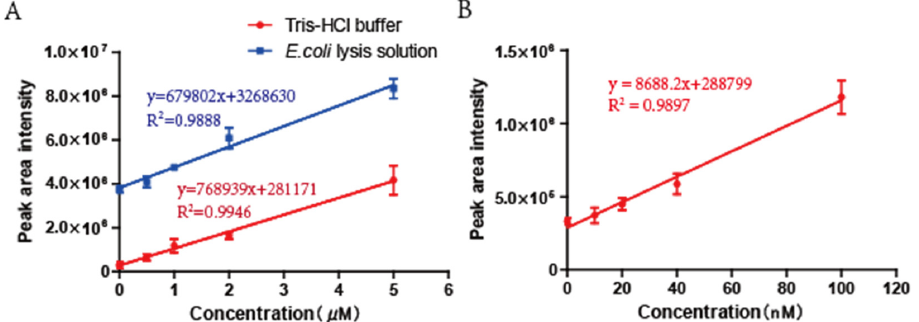
Figure 3. The standard curves of bimane-S 2 O 32 − range at different concentrations. The standard curves of bimane-S 2 O 3 2 − were established ranging from 0 to 5 µ M ( A ) and 0 to 0.1 µ M ( B ), respectively. The curve in blue color is plotted with cell lysate of E. coli BL21(DE3) as a complex background, and the curve in red color is plotted with Tris-HCl buffer as a plain background. Three parallel experiments were performed to obtain the averages and standard deviations (n = 3).